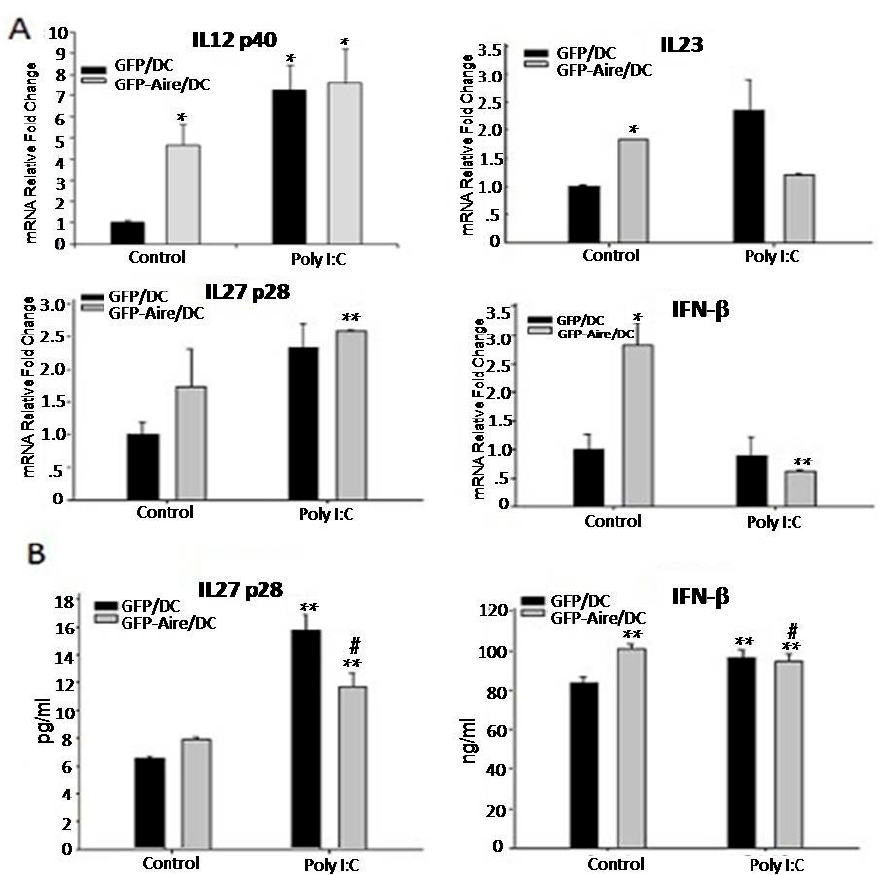
Figure 3. The effects of Aire on gene expression downstream of TLR3 in GFP-Aire/DC. ( A ) The IL-12 p40, IL-23, IL-27 p28, and IFN- β transcript expression levels in GFP-Aire/DC and GFP/DC cells were detected by RT-qPCR. All qPCR data are shown as the expression relative to that of GAPDH and are depicted as fold-change relative to the expression in GFP/DC cells, which was normalized to 1; and ( B ) The IL-27 p28 and IFN- β protein concentrations in GFP-Aire/DC and GFP/DC cells were analyzed by ELISA. Data are shown as the means ± SD from three to six independent experiments. * p < 0.05 and ** p < 0.01 compared with the GFP/DC control; # p < 0.05 compared with the GFP-Aire/DC control.